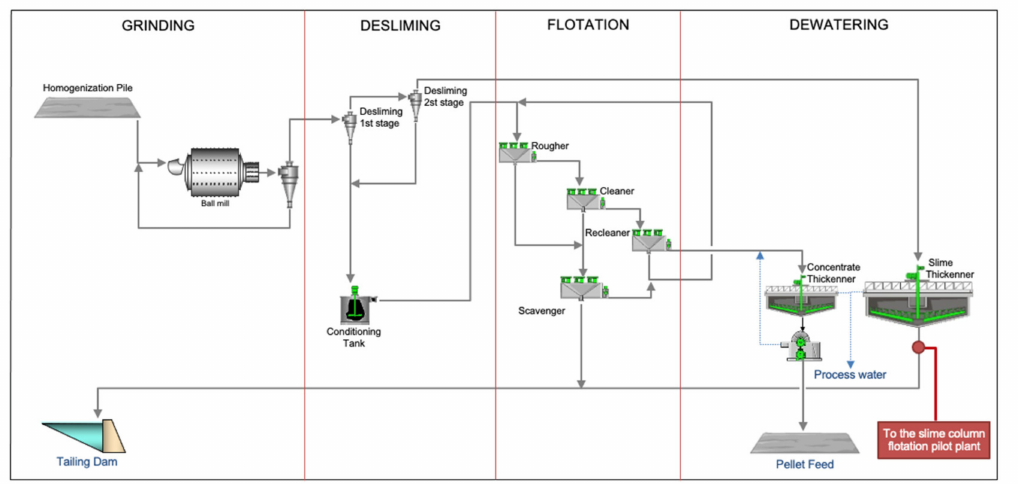
Figure 1. Simplified flowsheet of Vargem Grande 2 industrial plant. The slime (overflow of second desliming stage—10 inch hydrocyclones) feeds the slime thickener (diameter 100 m). The underflow of the slime thickener is sent to the tailings